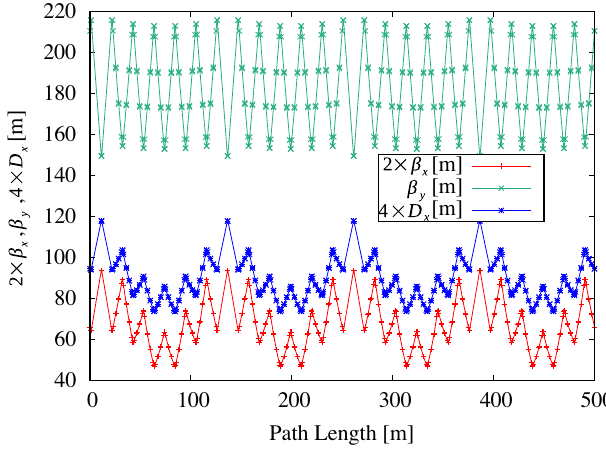
FIG. 2. Twiss parameters and dispersion for the entire circum- ference of the all-electric proton EDM